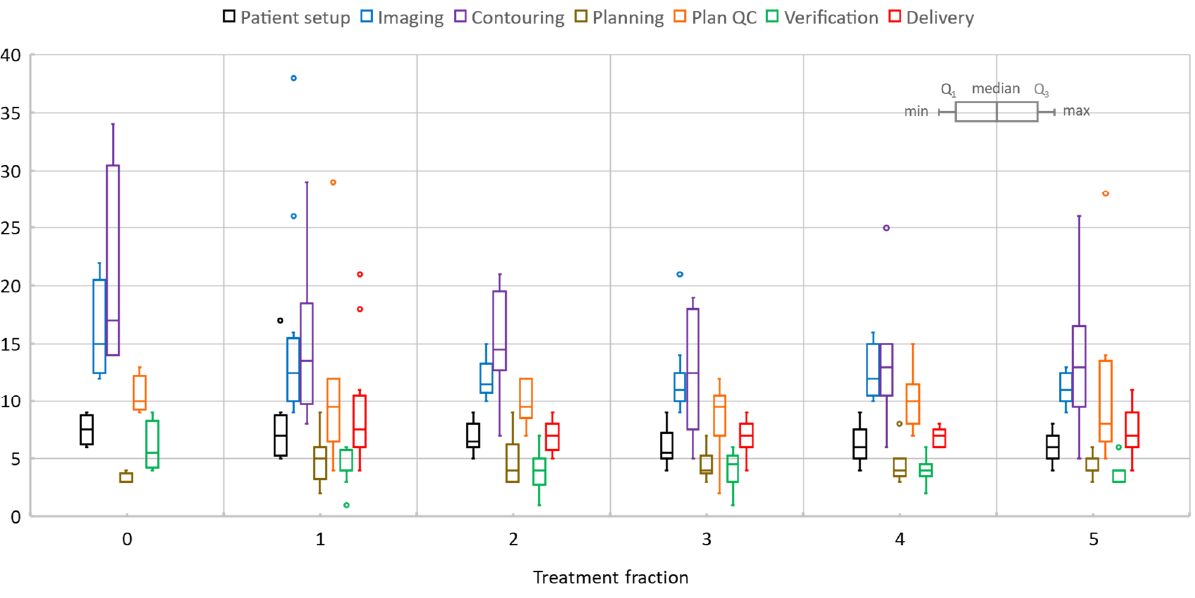
Figure 8. Pancreas online adaptive sessions, all including five fractions. The time spent on key pro- cesses in the adapt-to-shape workflow. Similarly, for pancreas, the patient setup time was 5.1/2–8 min, imaging took 13.8/9– 26 min, registration and contouring time was 14.6/7–28 min, planning time was 5.3/3–8 min, physics plan QA time was 6.9/5–9 min, verification time was 3.9/3–5 min, and treat- ment delivery time was 8.3/5–12 min. When the T2w-Ave scan was selected as the plan- ning data set, an additional 3D scan with T1-weighted contrast (2 min long) was acquired to activate the online TSM workflow since the T2w-Ave sequence was not part of the pre- defined TSM exam cards. Plan QA and secondary MU calculations included issues related to data transfer and post-processing in RayStation. The treatment time also included beam faults and associated tasks required to remediate and resume the beam delivery.